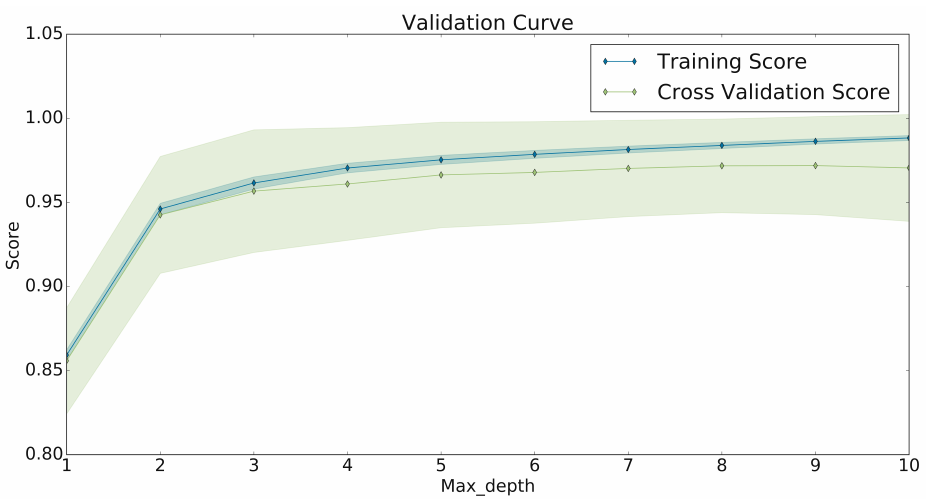
Figure 12. 10-CV flowchart using the R 2